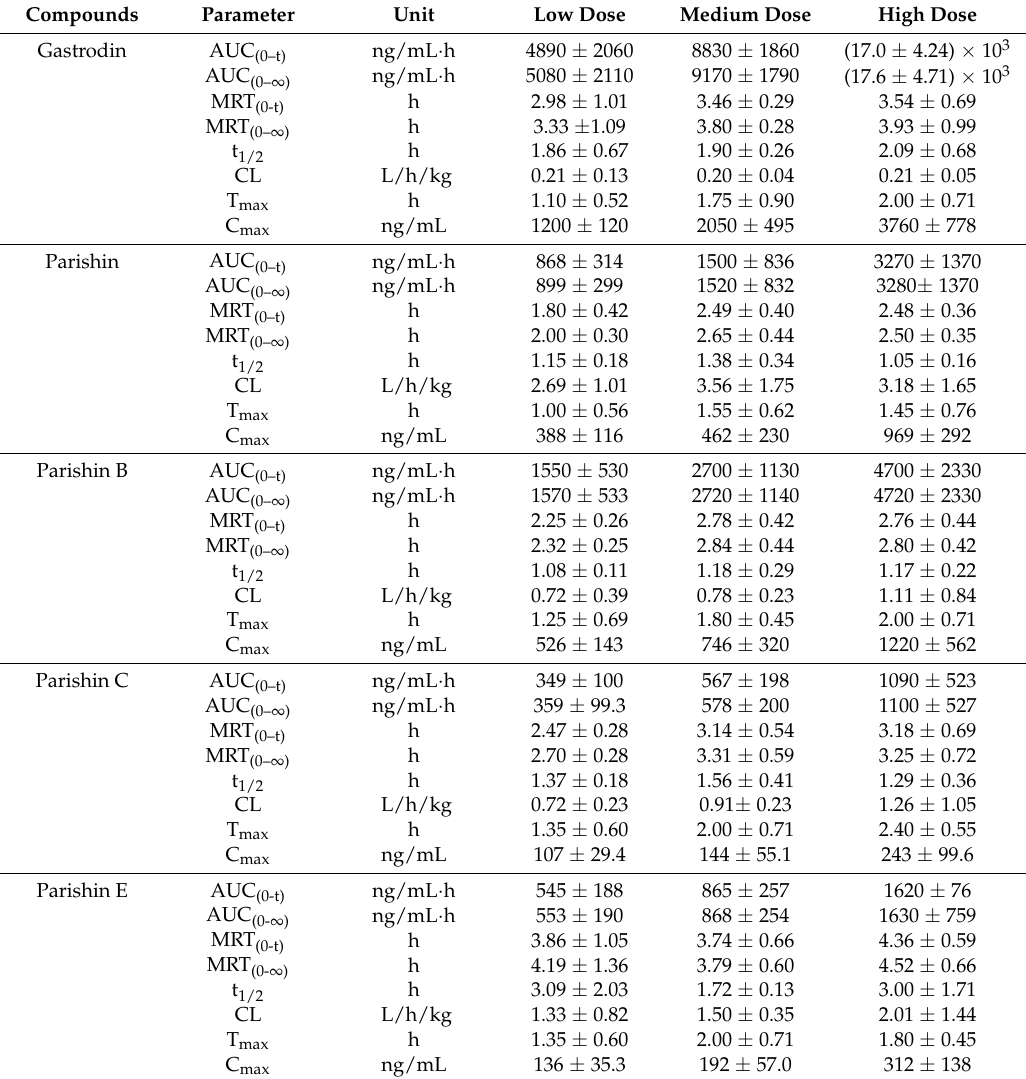
Table 3. The mean plasma pharmacokinetic parameters under low, medium and high doses of the five analytes ( n =